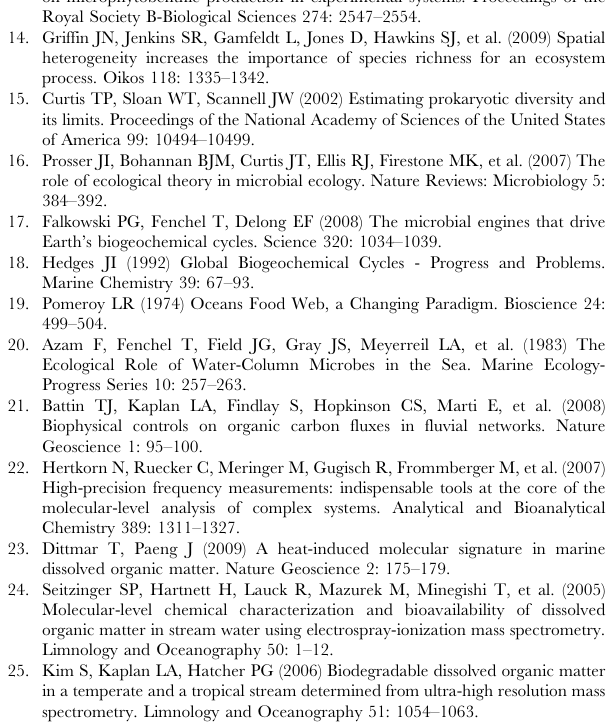
Table S2 Water-related environmental background conditions (nutrient concentrations, DOC concentrations and temperature) measured at the outlet of mesocosms and in the header tank.